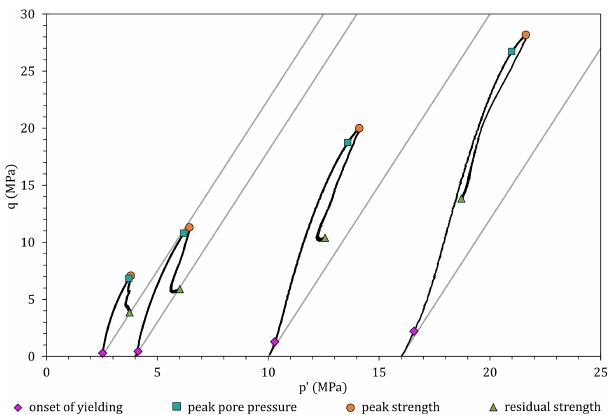
Figure 5. Effective stress paths for samples with consolidation stresses 2.5, 4, 10, and 16MPa. The grey lines represent the the- oretical drained stress path, i.e. constant pore